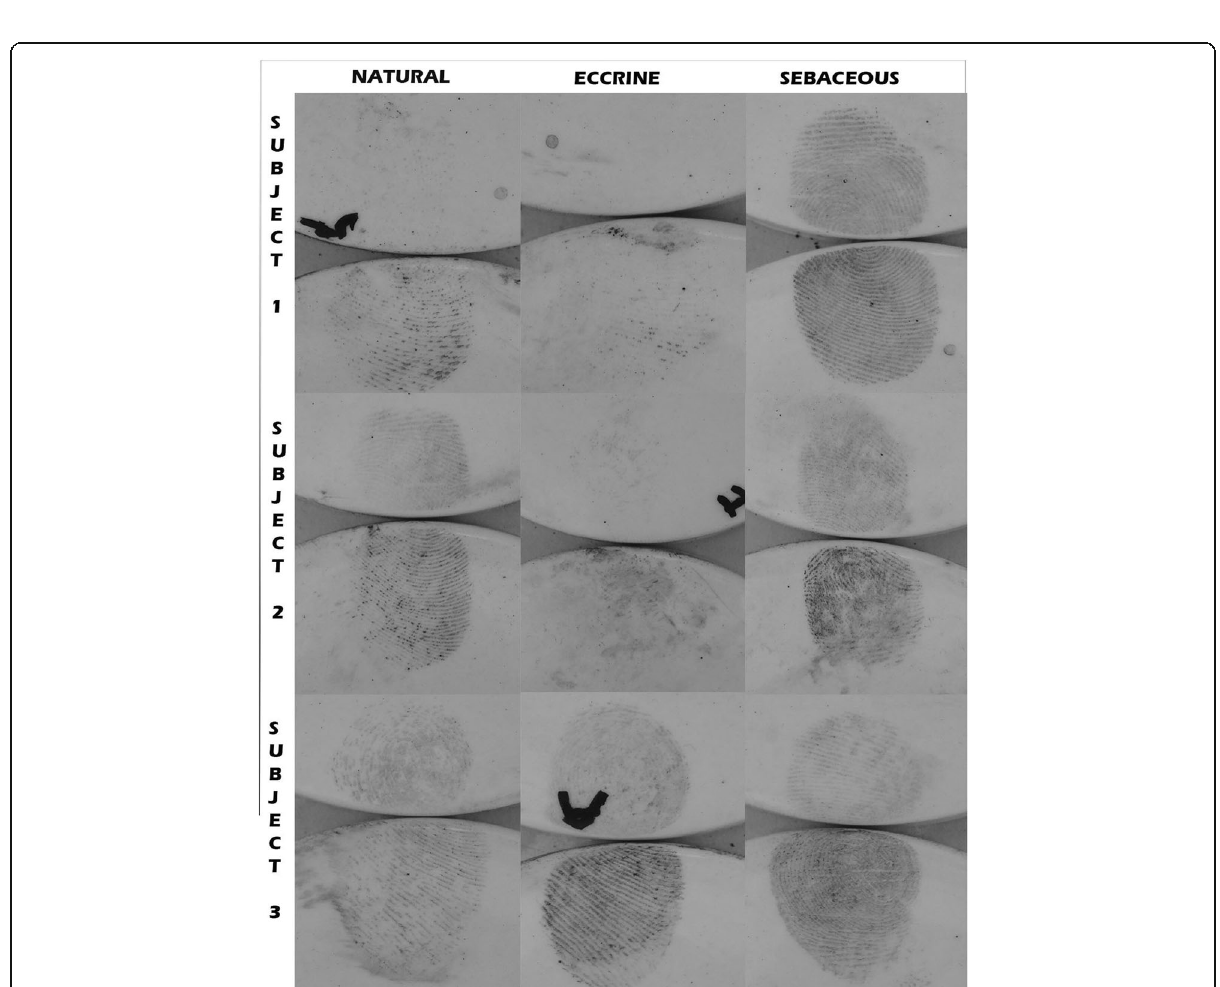
Fig. 2 Latent fingermarks of natural, eccrine and sebaceous origin from three varied subjects with upper half developed using NP, and lower half developed using